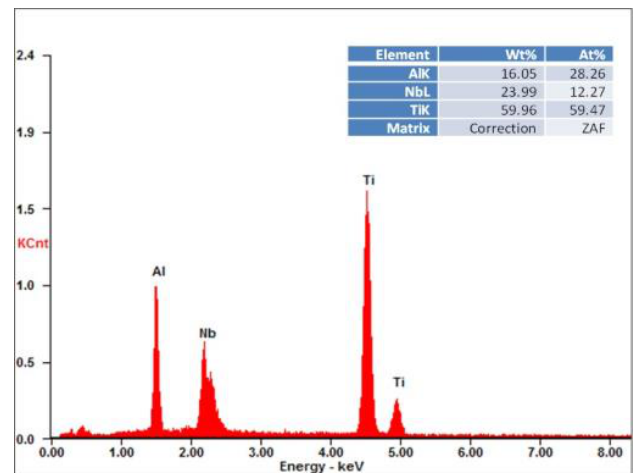
Figure 4. EDS analysis results of tested alloy.